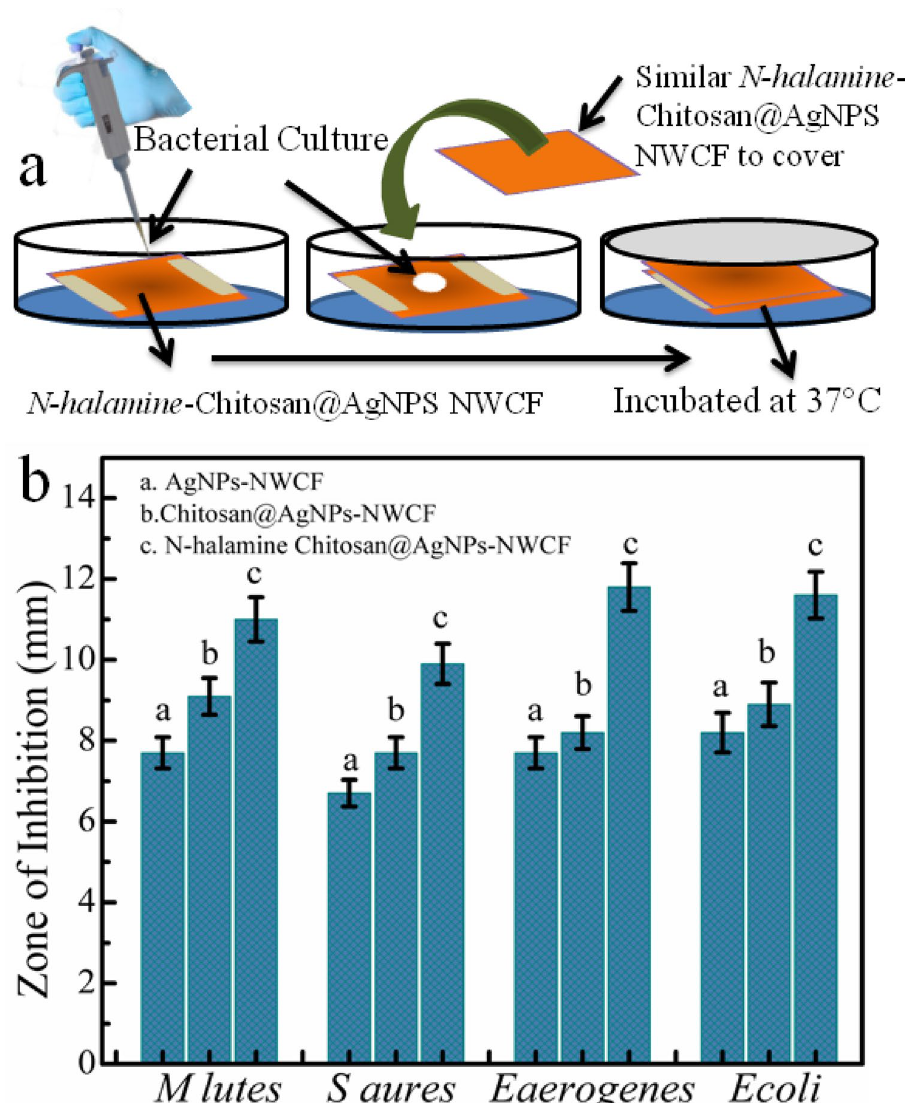
Figure 6. Schematic illustration ( a ) for measurement of antimicrobial efficacy of nonwoven cotton fabric, the response of growth inhibition zone ( b ) of AgNPs-NWCF (Control-I), chitosan@AgNPs-NWCF (Control-II), and N-halamine s-chitosan@AgNPs-NWCF (Sample) for four types of bacteria. An error bar has been added for n = 3. The trend line at bars shows bacterial response behavior for AgNPs-NWCF (control I), chitosan@AgNPs- NWCF (II), and N-halamine s-chitosan@AgNPs-NWCF